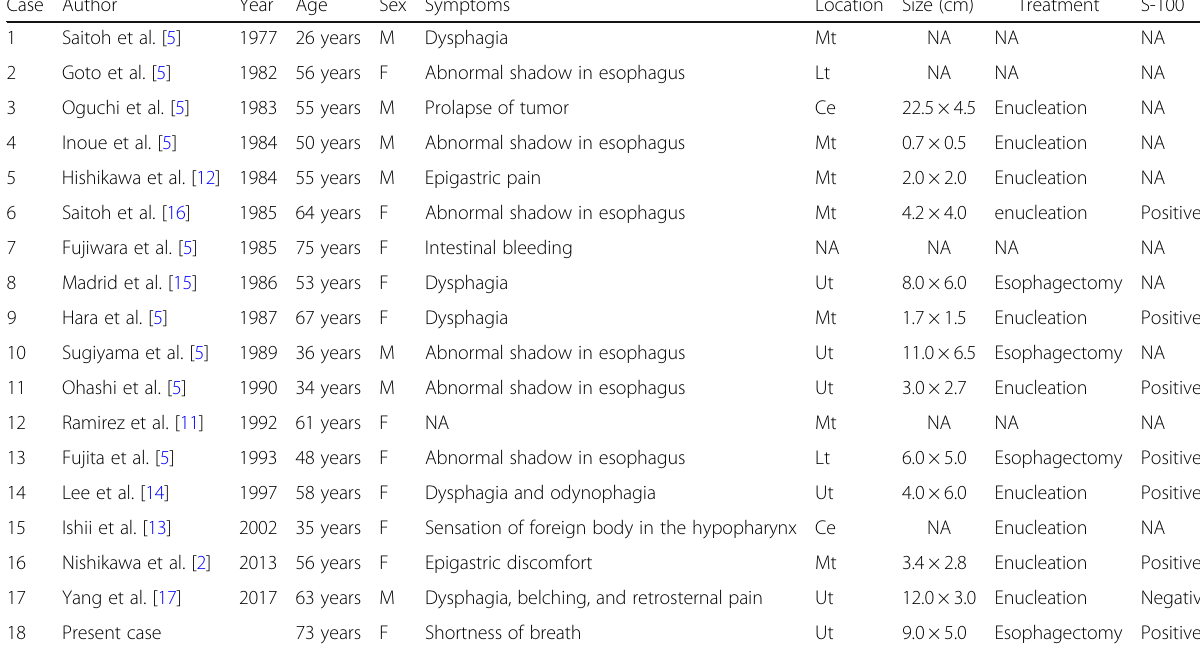
Table 1 Reported cases of esophageal